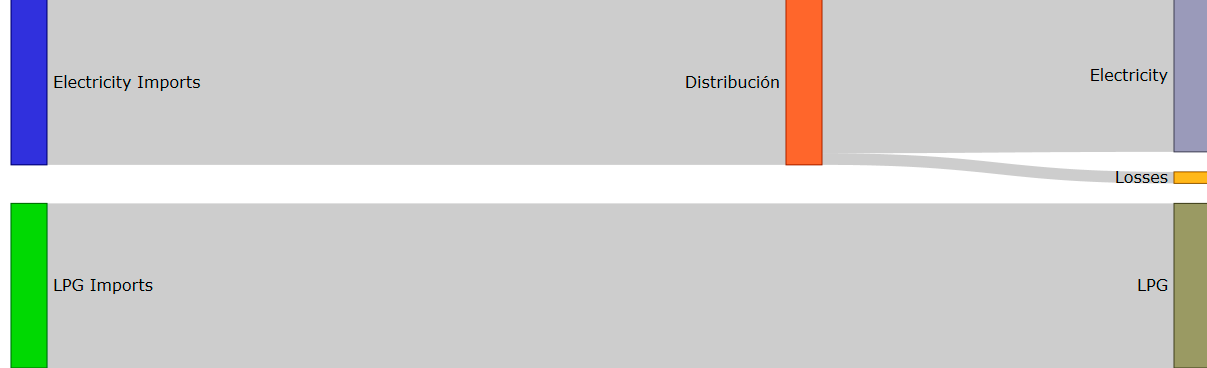
Figure 9. Scenario 3. Sankey diagram for 2030, residential Figure 11. Scenario 3. Sankey diagram for 2030, residential sector.